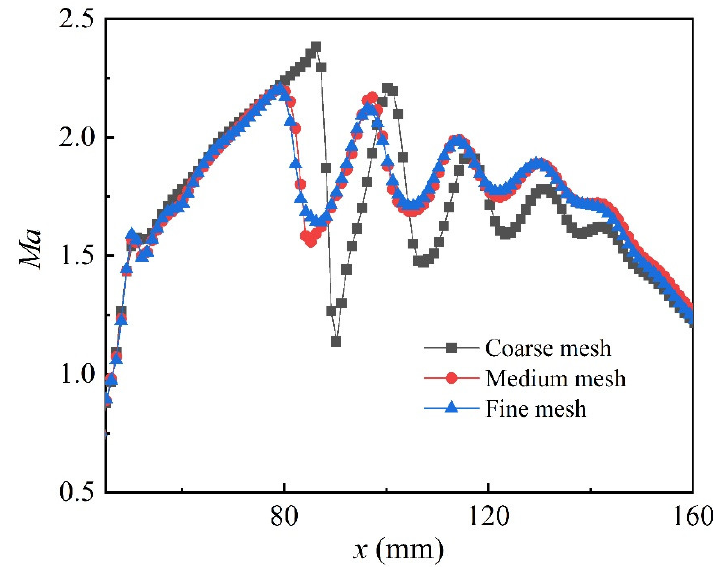
Figure 3. Mesh independence study using Mach number along the centerline of the mixing chamber. Table 2. Calculated results of the GCI